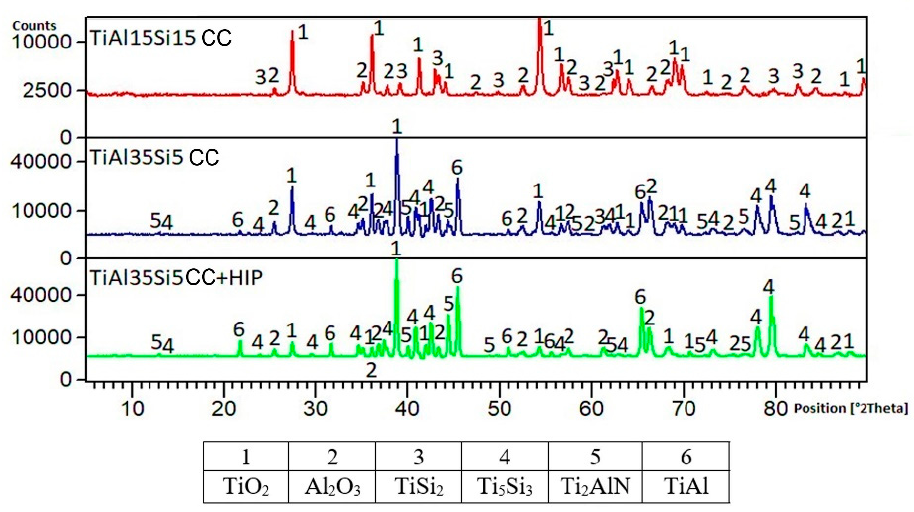
Figure 8. Phase composition of the surface oxide layer of Ti-Al-Si alloys after cyclic oxidation at 800°C.